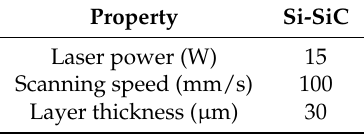
Figure 4. The 4-step approach to produce ceramic hemispheres using additive manufacturing. Table 2. Laser sinter parameters for Si-SiC